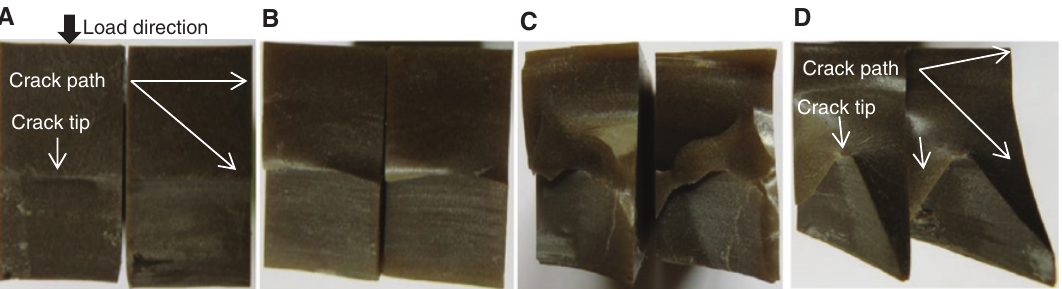
Figure 7: Fracture surfaces of SENB specimens at SSA content of 15 wt% for: (A) mode I θ = 90 ° , (B) mixed-mode θ = 75 ° , (C) mixed-mode θ = 45 ° , (D) mixed-mode θ = 30 ° .